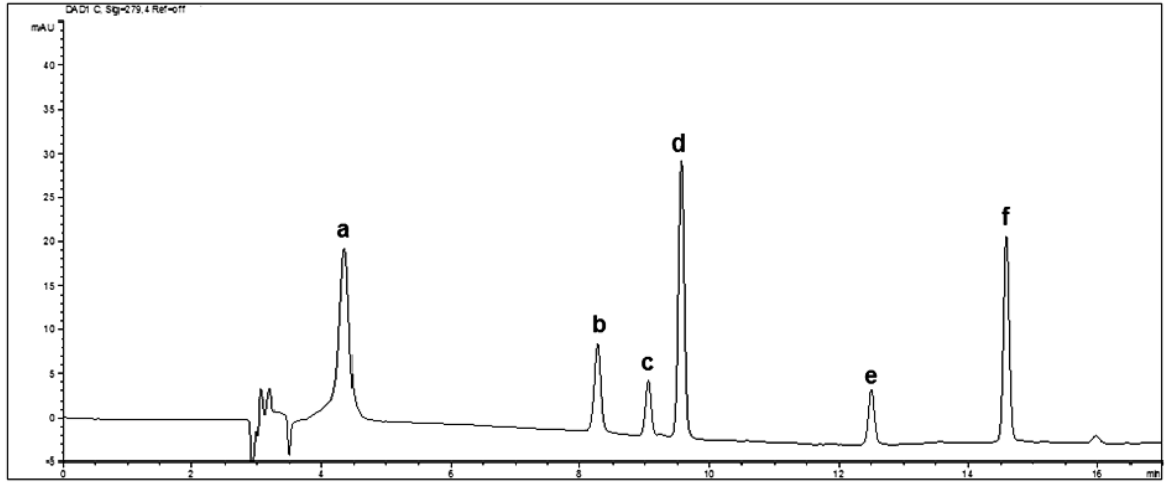
Figure 2. HPLC chromatograms of polyphenol standards at 279 nm ( a gallic acid, b chlorogenic acid, c (-)-epicatechin, d syringic acid, e rutin and f psoralen).